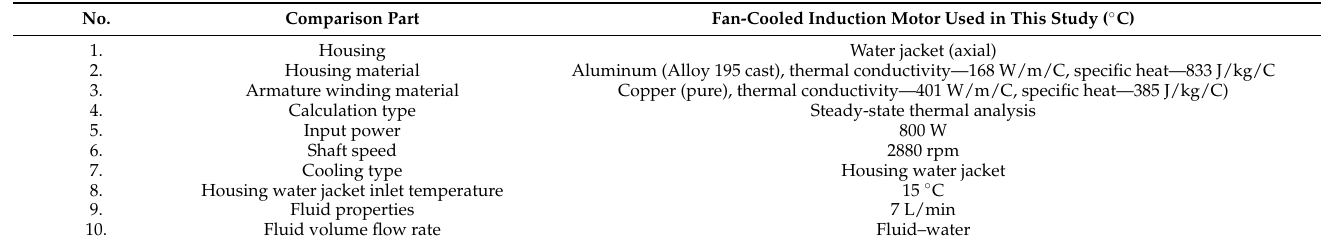
Table 8. Input parameters for thermal analysis on water-cooled motor with aluminum casing (ANSYS Motor-CAD).